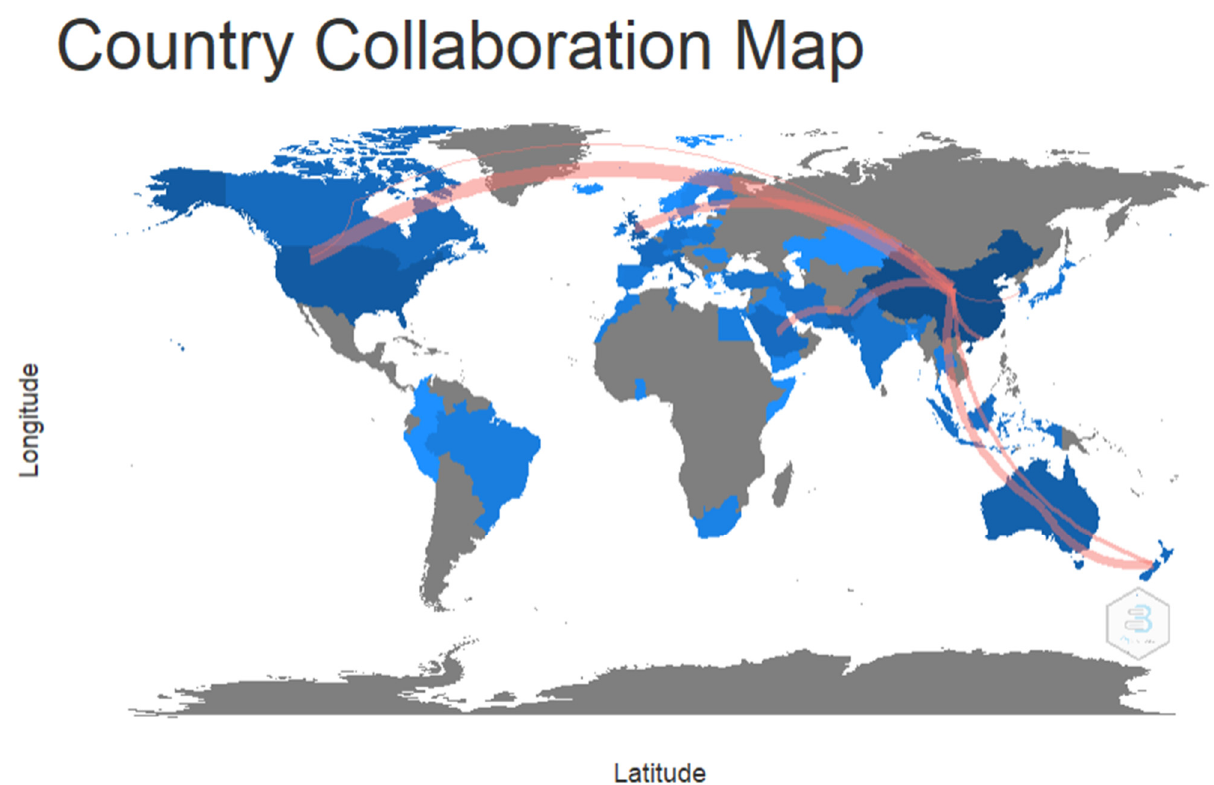
Figure 5. Country collaboration map. Source: Scopus/Biblioshiny.